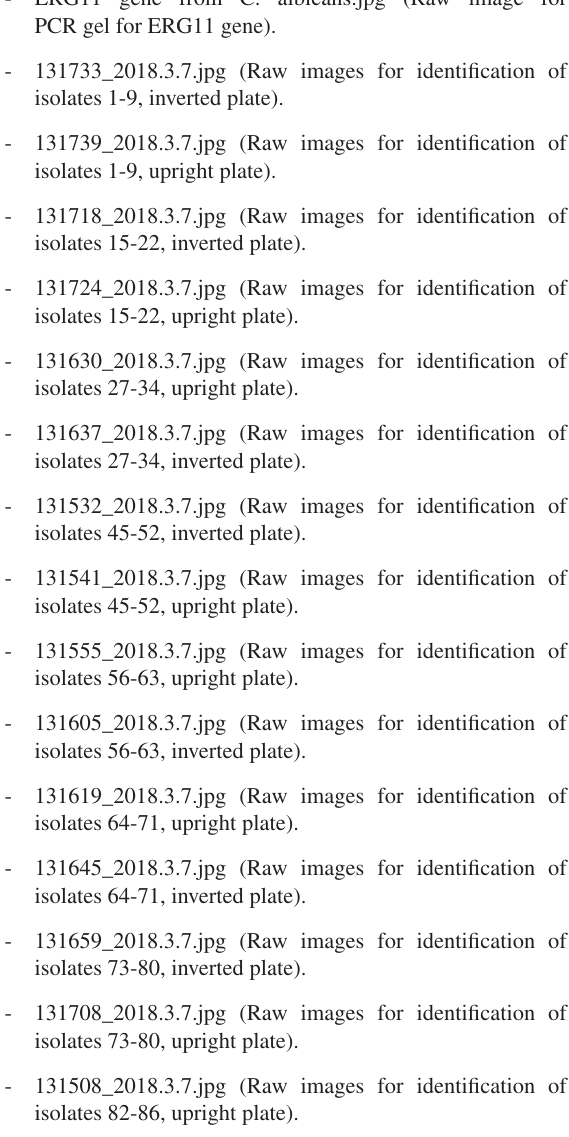
Figshare: candida identification using Hi-chrome media and gel electrophoresis for ERG11 gene. https://doi.org/10.6084/ m9.figshare.12775769.v1